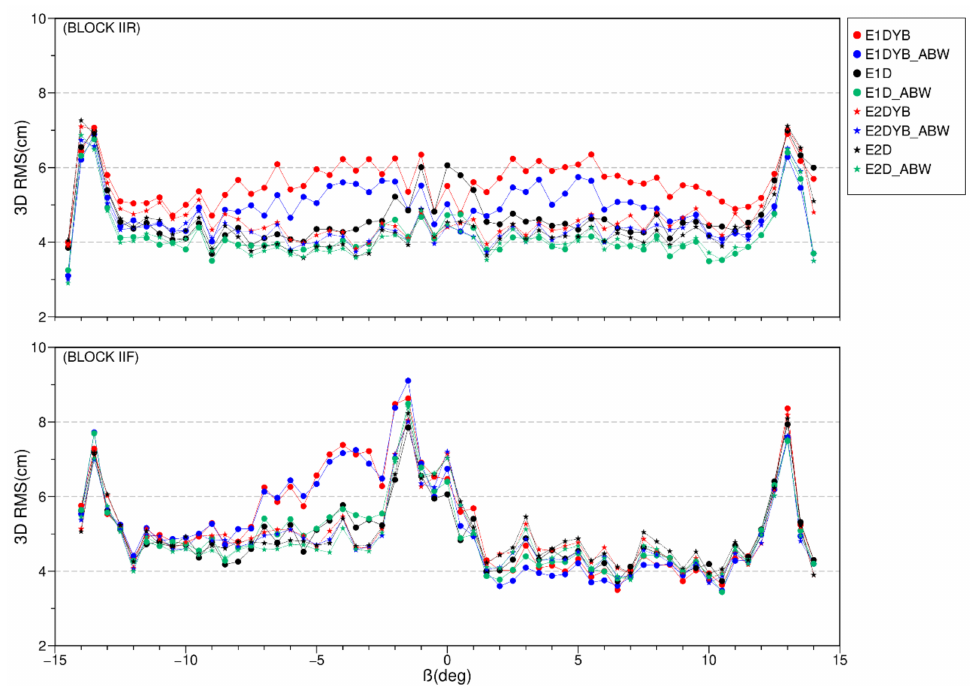
Figure 11. 3D RMS values of DBD for BLOCK IIR ( upper panel ) and BLOCK IIF ( lower panel ) in eclipse seasons with respect to the β angle spanning from 2017 to 2019. Note that there is no difference between using no a priori SRP model and using the box-wing model; the solutions using the box-wing model are thus not